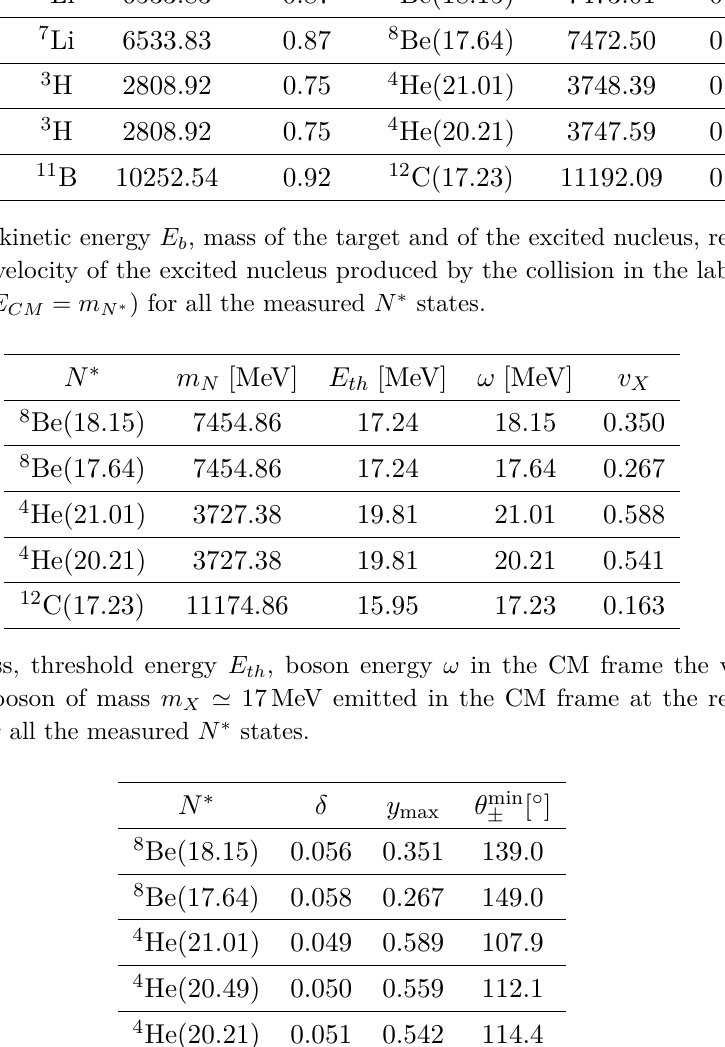
= 17 MeV emitted in the CM X